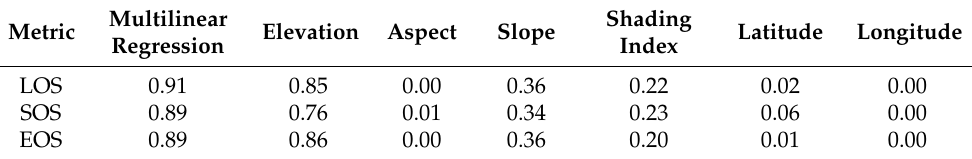
Table 2. Variance explained by multilinear regression and linear regression of individual variables against the three metrics in the GAR. Each cell reports the R 2